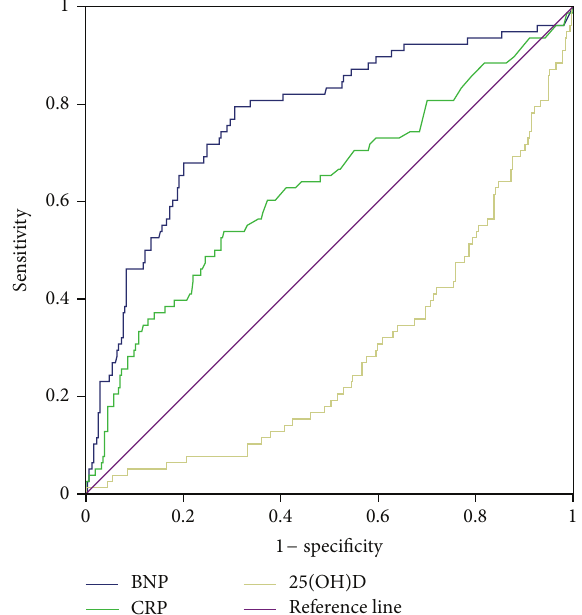
Figure 2: Receiver operating characteristic curves for 25(OH)D, BNP, and hsCRP for evaluation of all-cause mortality in the female patient